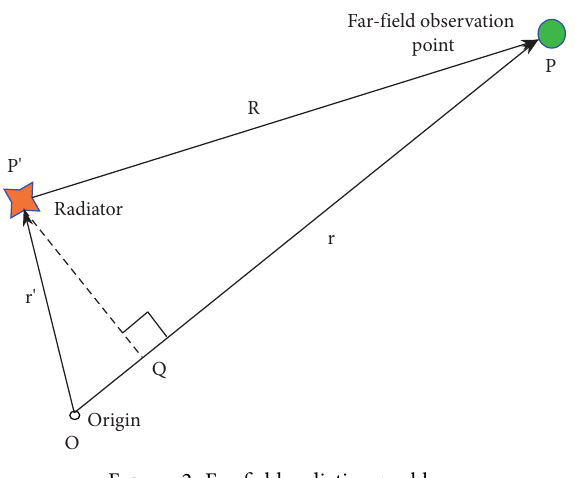
Figure 2: Far-feld radiation